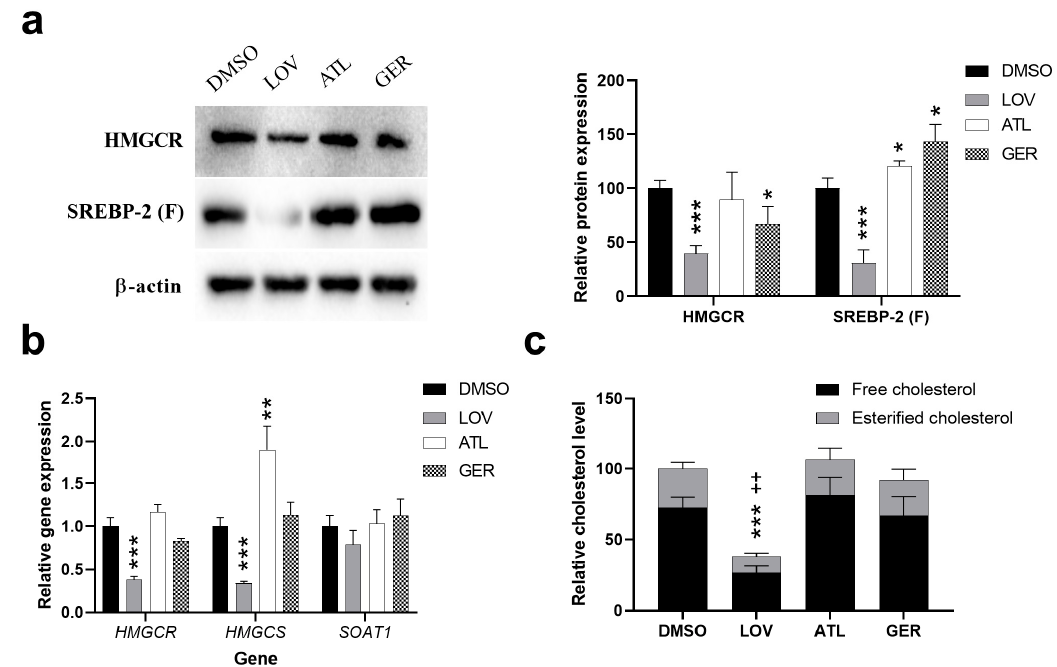
Figure 5. Changes in cholesterol metabolism after a multiple exposure experiment (4-day exposure with medium change every 24 h, cells collected 12 h after the last treatment). ( a ) Representative western blots and relative protein expression changes showing expression changes in HMGCR and SREBP-2 after normalization to β -actin. ( b ) Relative gene expression changes in HMGCR , HMGCS, and Soat1 mRNA by RT-qPCR. ( c ) Cholesterol levels in differentiated HepaRG cells after multiple exposure treatment. Results are expressed as the mean ± SD from three independent experiments. * statistical significance for free cholesterol level change; + statistical significance for esterified cholesterol). Results statistically significant: p < 0.05 (* or +), p < 0.01 (** or ++), p < 0.001 (*** or +++).